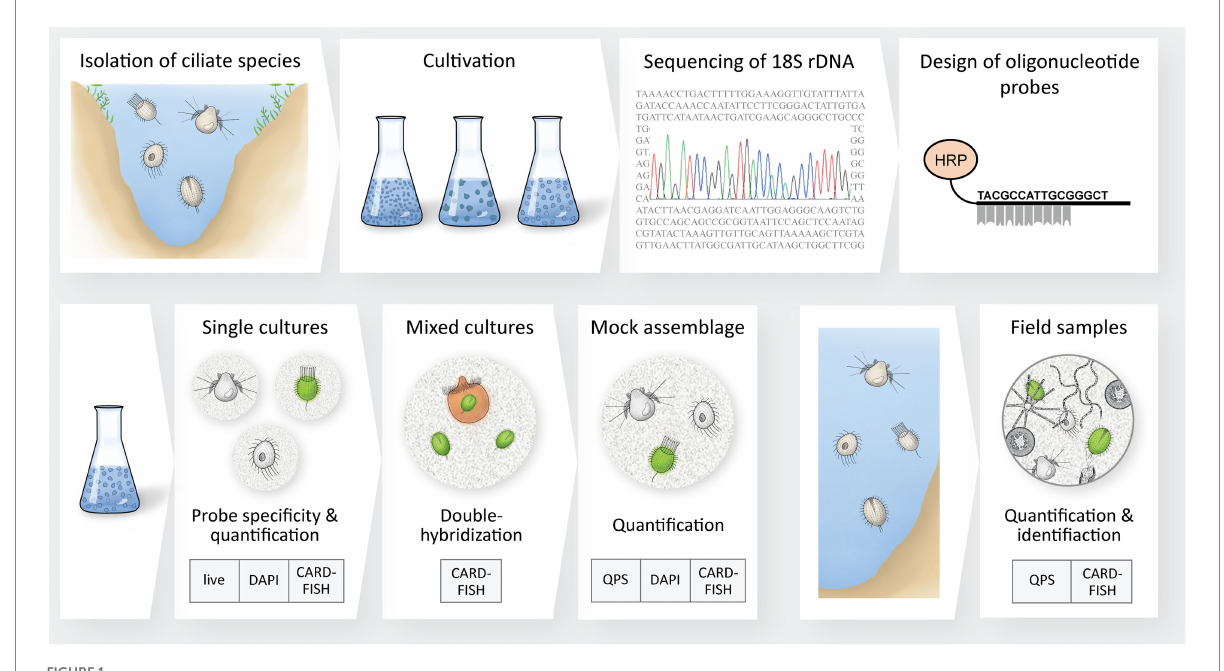
FIGURE 1 Overview of the workflow used to elaborate a protocol for the identification and quantification of planktonic freshwater ciliates via CARD-FISH. Nine ciliates species were collected and cultivated before their 18S rDNA was sequenced. Newly designed oligonucleotide probes for CARD-FISH were designed and first tested on cultures (single and mixed cultures, mock assemblage) and thereafter on ciliates from lake water samples. We tested the specificity of all probes and proved the quantitative properties of CARD-FISH by comparisons between live cell counts, QPS and DAPI